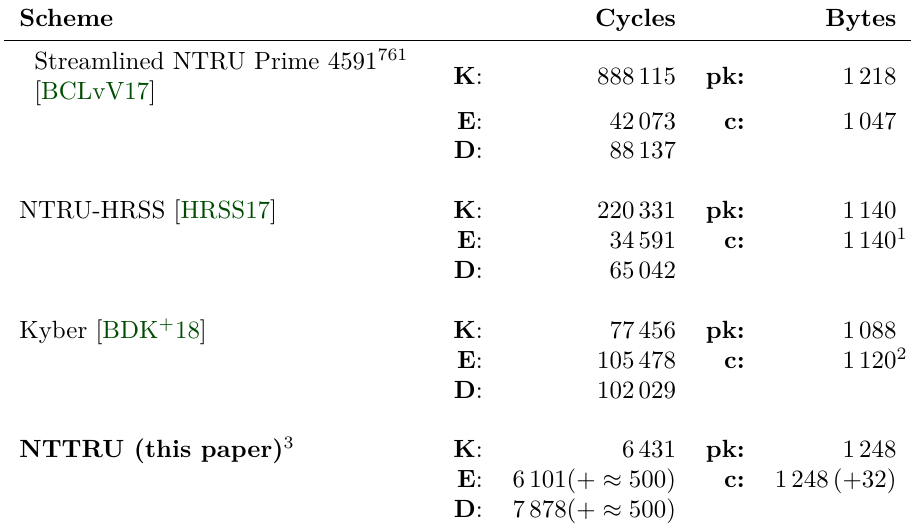
Table 1: Comparison of lattice-based IND-CCA2 secure KEMs. Cycle counts are medians of many executions of key generation ( K ), encapsulation ( E ) and decapsulation ( D ). Measurements for all schemes except NTTRU (this work) were obtained in the supercop- 20190110 benchmarking run on a machine called “samba” with an Intel Skylake Xeon E3-1220 CPU. NTTRU was benchmarked on a laptop with an Intel Skylake i7-6600U CPU. Bytes are given for public keys ( pk ) and ciphertexts ( c